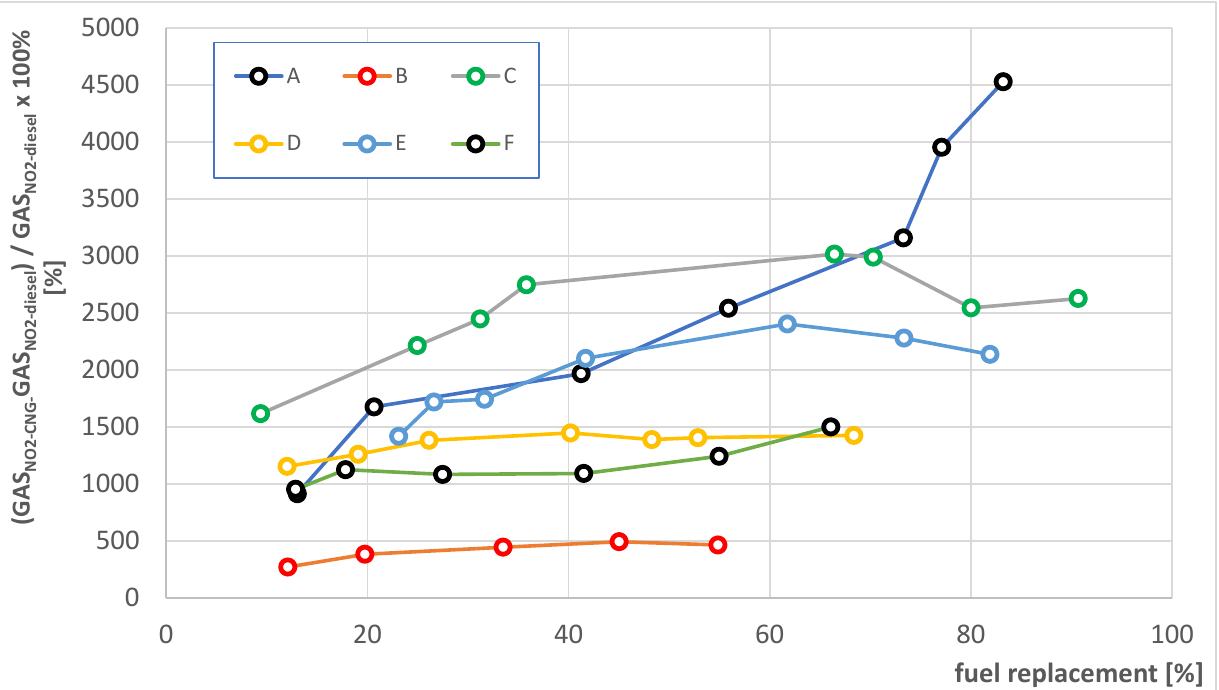
Figure 7. Curves from A to F showing engine’s emission of NO 2 (nitrogen dioxide), for individual engine operating points, where the rotation speed, power, and torque were constant, as a replacement function of diesel fuel replaced by CNG.